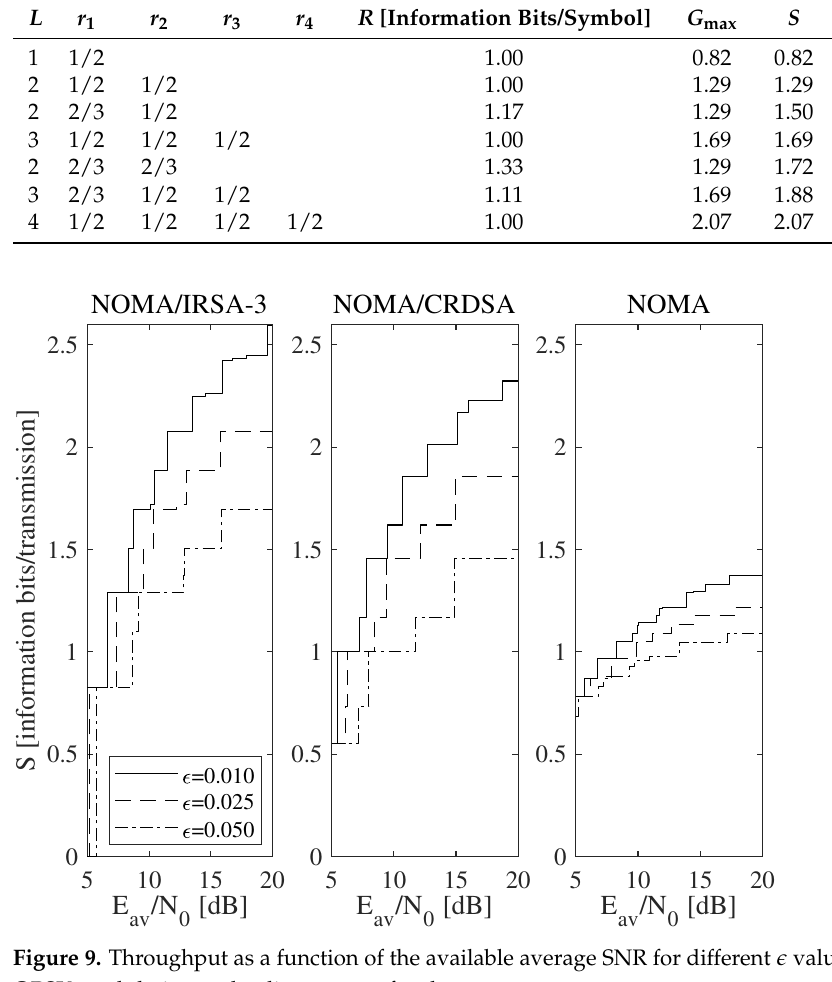
Figure 9. Throughput as a function of the available average SNR for different (cid:101) values assuming the QPSK modulation and a discrete set of code